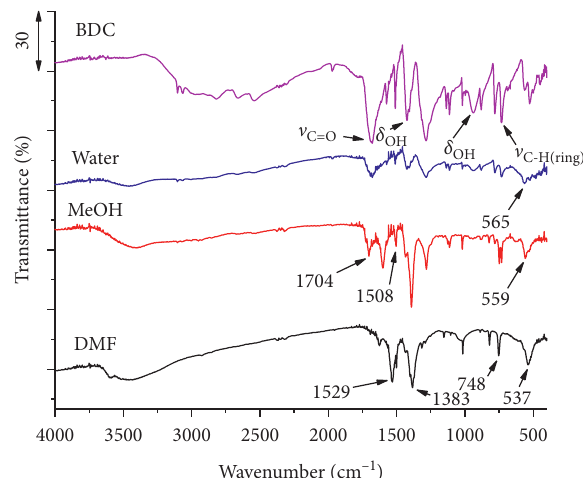
Figure 2: FT-IR spectra of iron (III) benzene dicarboxylate samples synthesized in the solvents and